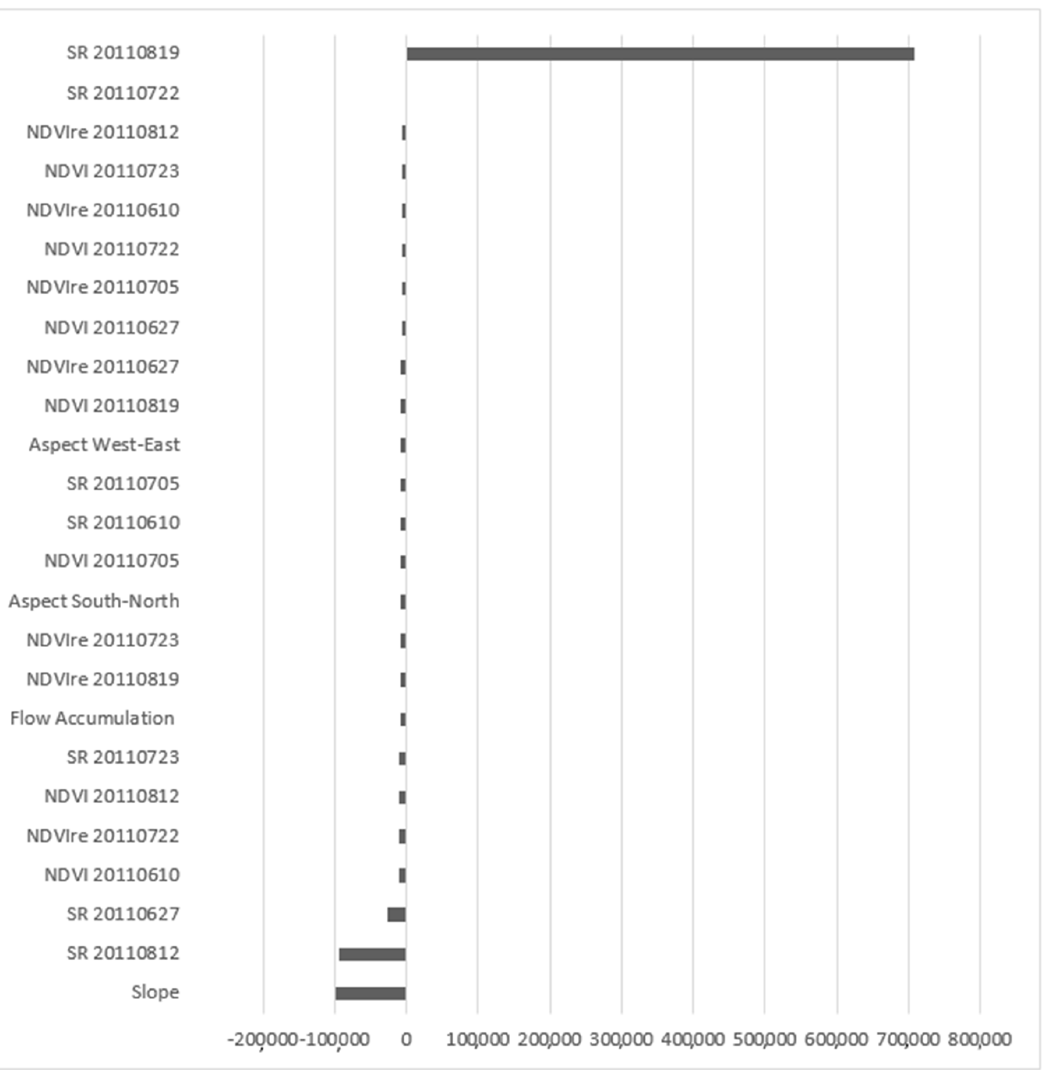
Figure A2. Importance of variables for the soybean 2011 ANN model, as measured by Connection weights (larger positive or negative values indicate higher